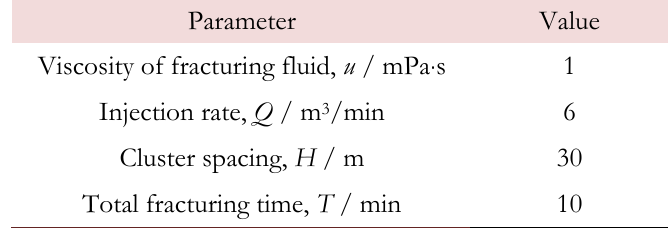
Table 2: Construction parameters of multi-cluster staged hydraulic fracturing.